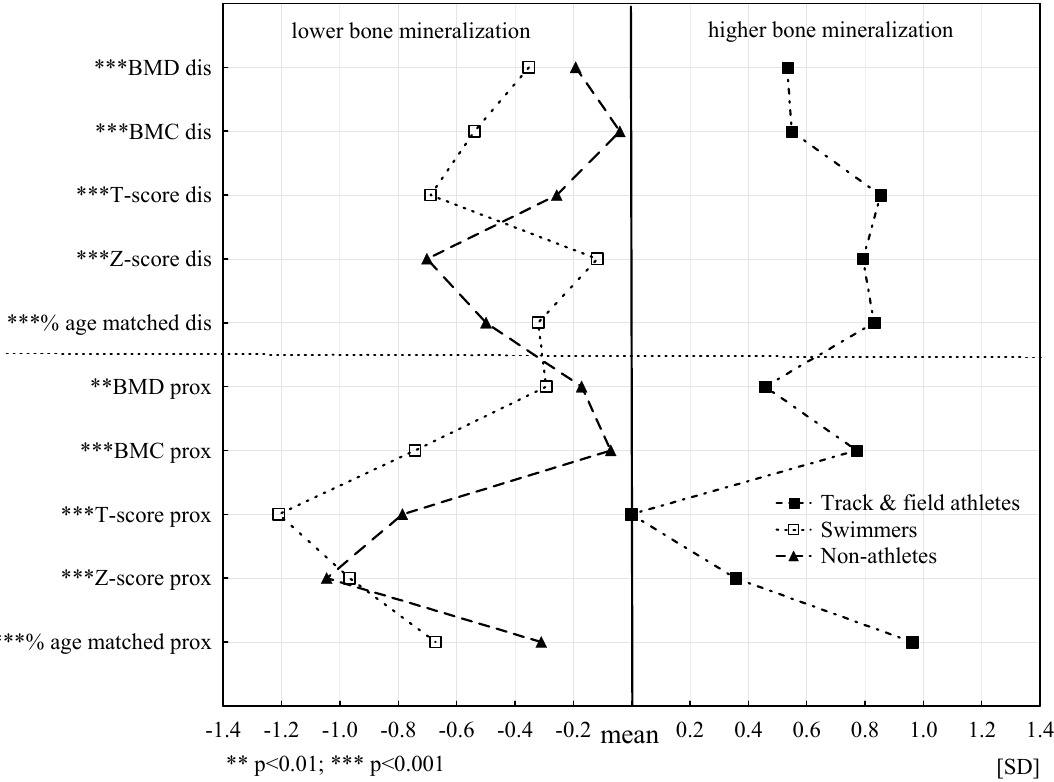
Figure 2. Biological profiles of the bone tissue mineralization state in three groups of PA.